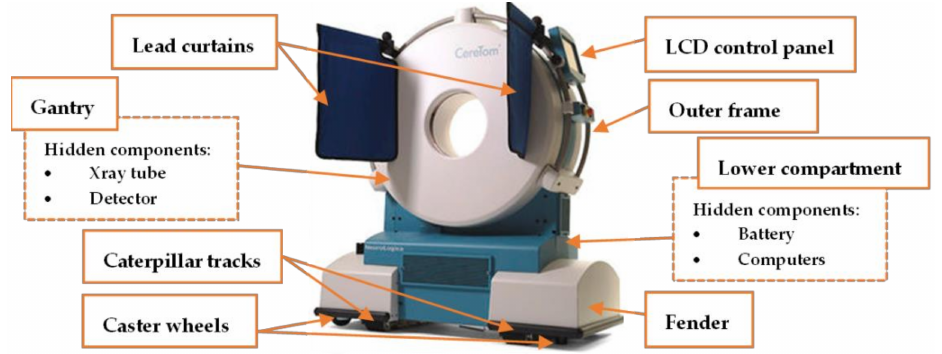
Figure 4. Components of CereTom by